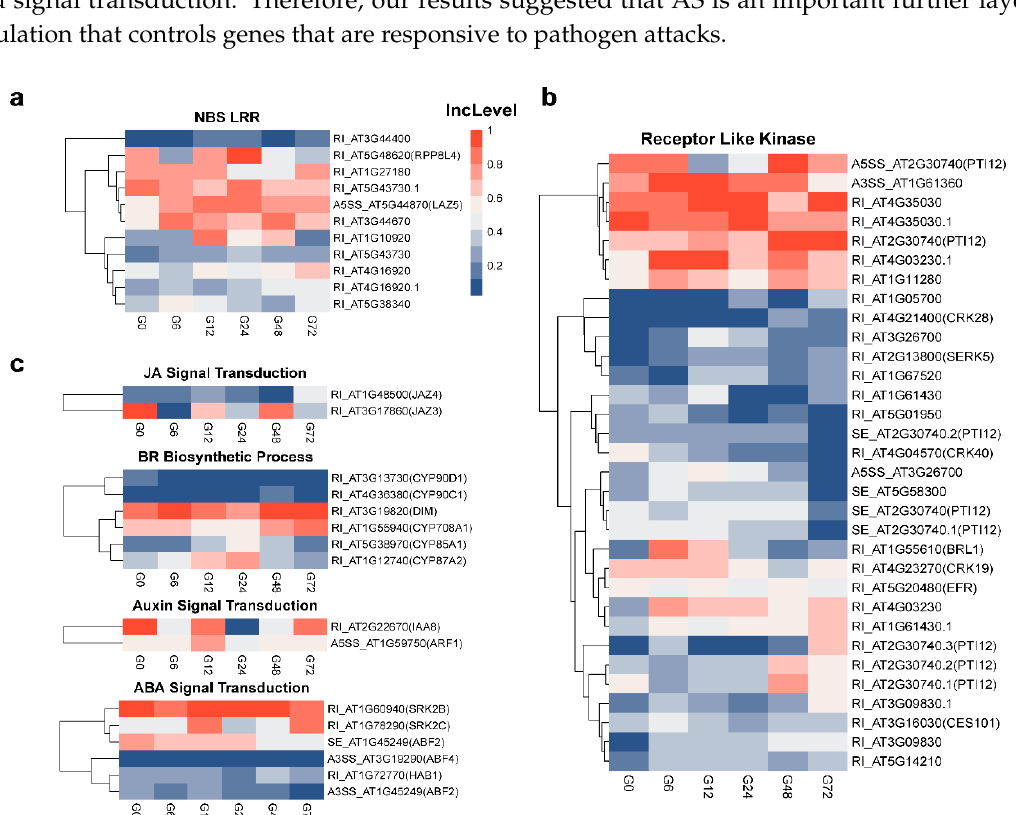
Figure 6. Experimental validation of defense-related events by reverse transcription (RT)-PCR in Arabidopsis thaliana . The bar charts show the relative percentages of isoform1 and isoform 2 during R. solanacearum infection according to IncLevel values. The asterisks show the significance compared to 0 h (G0). For the transcripts model, the red lines represent the coding areas and black arrows represent the RT-PCR primer binding sites. ATSKP1 ( AT1G75950 ) was used as an internal reference for